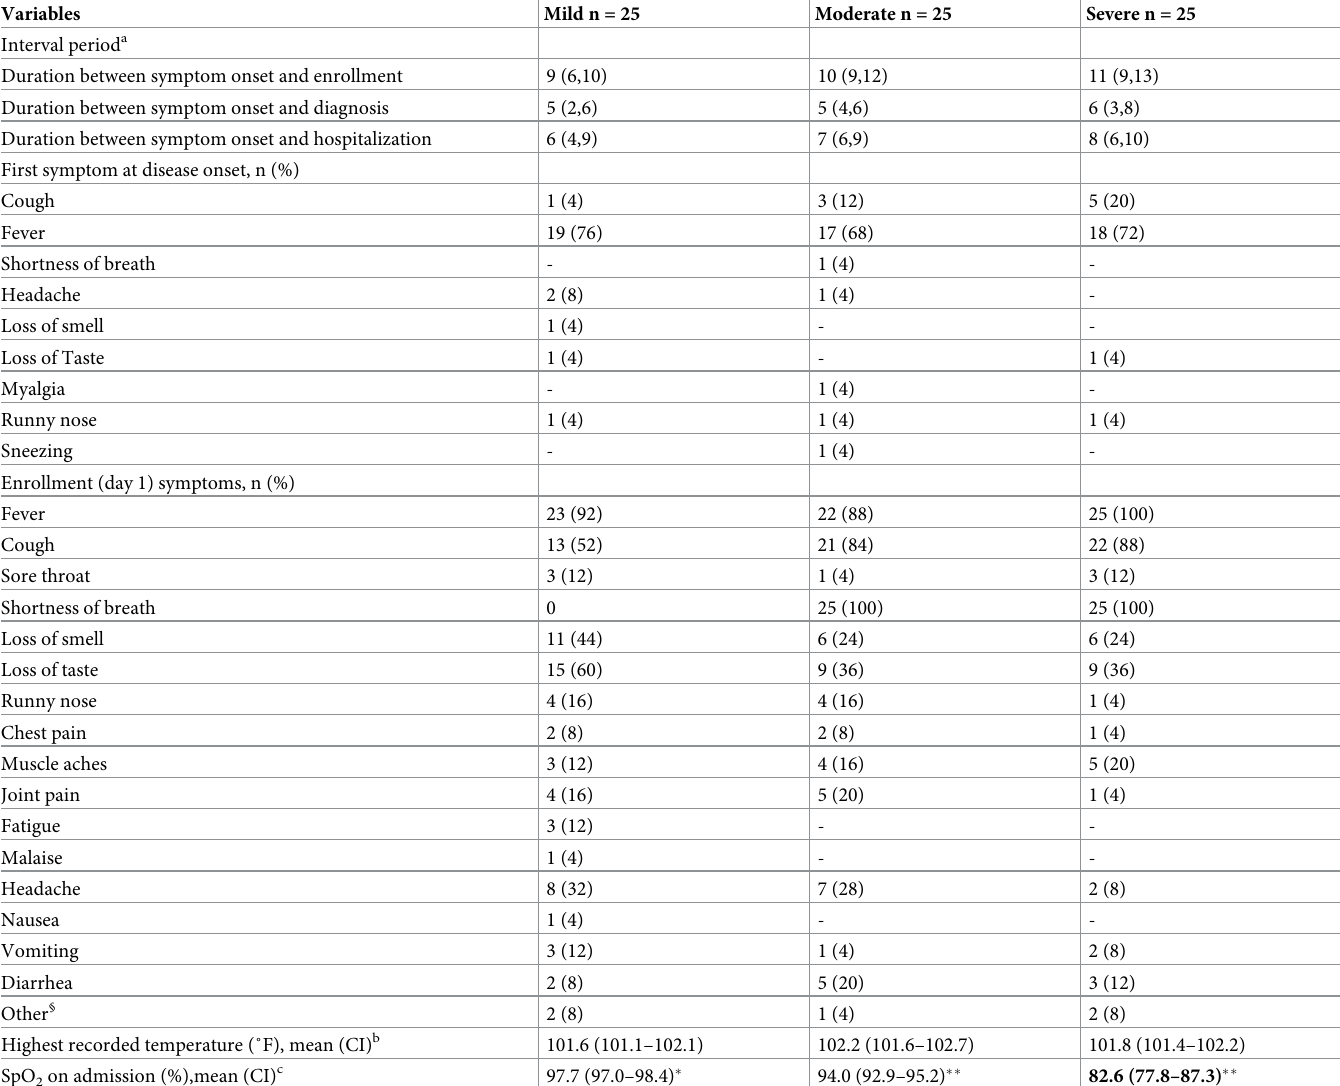
Table 2. Clinical characteristics of symptomatic COVID-19 patients with different severities at